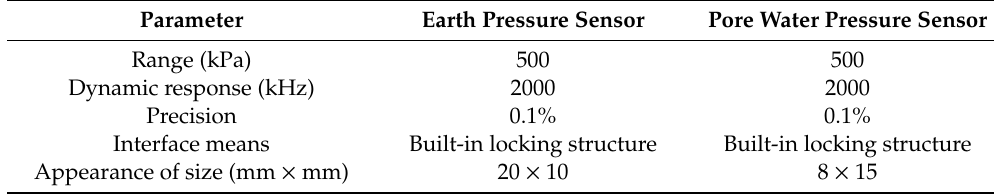
Table 1. Performance indexes of miniature silicon piezoresistive pressure sensor.